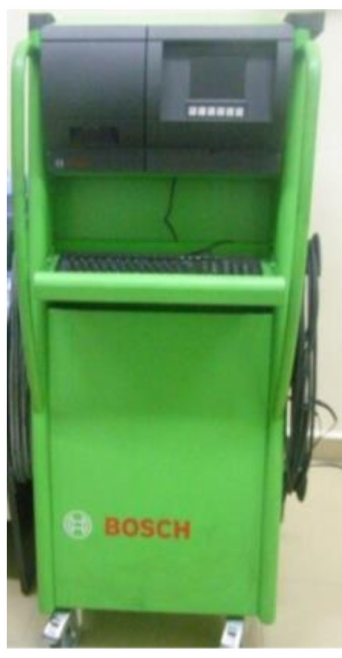
Figure 3. Photo of gas analyzer BOSCH